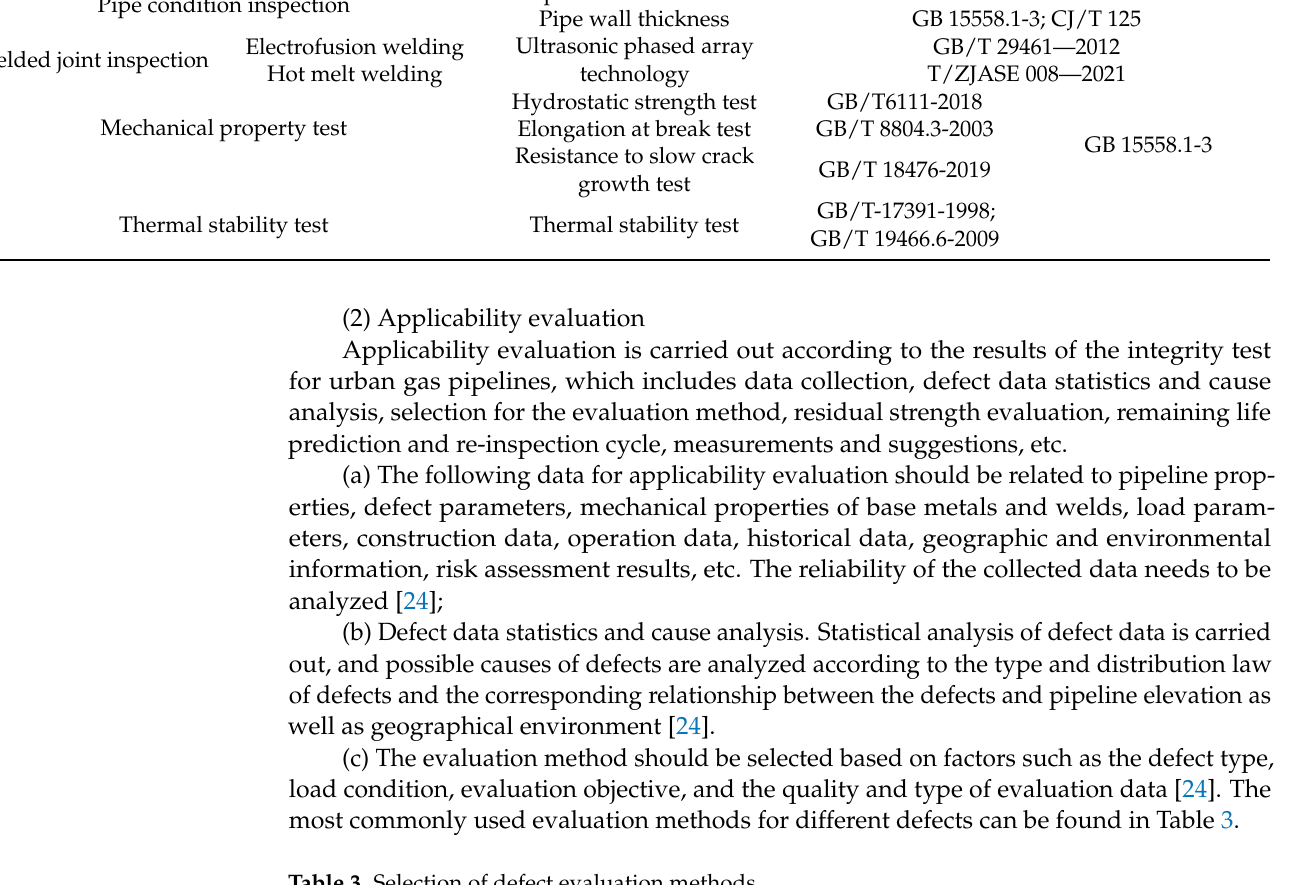
Table 3. Selection of defect evaluation